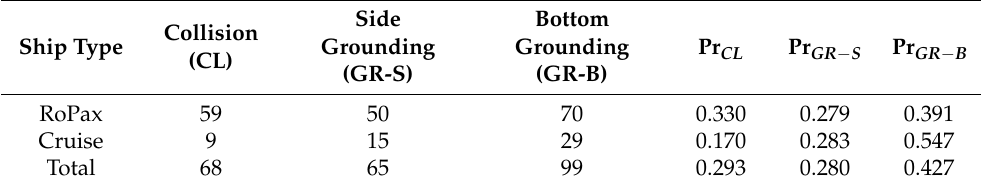
Table 2. Total number of accidents recorded and their respective weighting factors (irrespective of whether there is